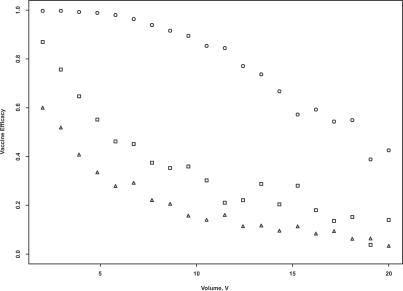
Vaccine Efficacy for Prevention as a Function of V, as Simulated from the Small-Volume, Stochastic Model for Three Values of R
0
The EPV was moderate (see Table 1 footnote), yielding a probability of infection-given exposure that ranged from 0.01–0.2, depending on V and R
0.10,000 stochastic simulations were used to produce each point in this figure.Circles, R
0 = 4; squares, R
0 = 10; and diamonds, R
0 = 20.